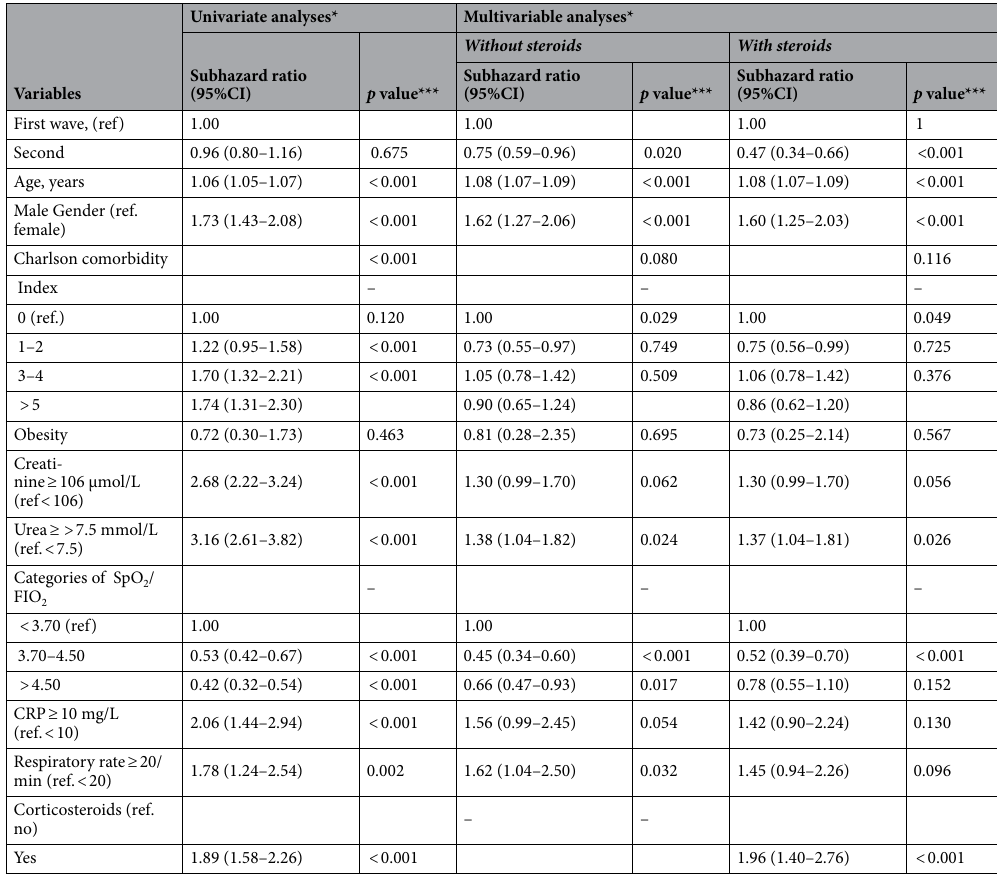
Table 4. Factors associated with in-hospital mortality during the two waves of COVID-19.